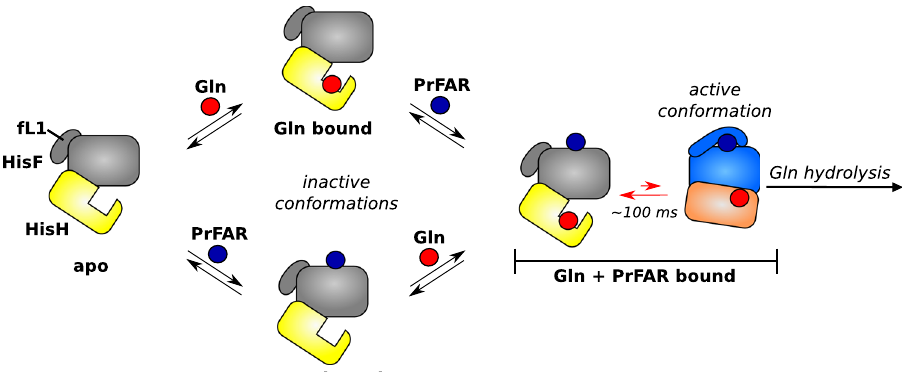
Fig. 5 Model of the allosteric activation pathway of the HisFH complex. The HisFH complex adopts the inactive conformation (gray and yellow) in the apo state (left) and in the presence of one of the two substrates (Gln: red; PrFAR: blue). In the inactive conformation fL1 of HisF is in the open orientation, the HisF – HisH interface is open and the oxyanion hole is not formed. Binding of the second ligand (either PrFAR or Gln) results in the formation of the HisFH:PrFAR:Gln complex. The presence of both ligands enables the formation of the active conformation of the complex (marine and orange). This active conformation is, however, only sparsely populated and in equilibrium (indicated by red arrows) with the inactive conformation (timescale ~100 ms). In the active conformation fL1 is closed over the PrFAR substrate in the HisF active site, the HisF – HisH domains are in a closed orientation and the oxyanion hole in the HisH active site is formed, which enables Gln hydrolysis. The population of the active conformation ultimately determines the overall catalytic rate of the HisFH